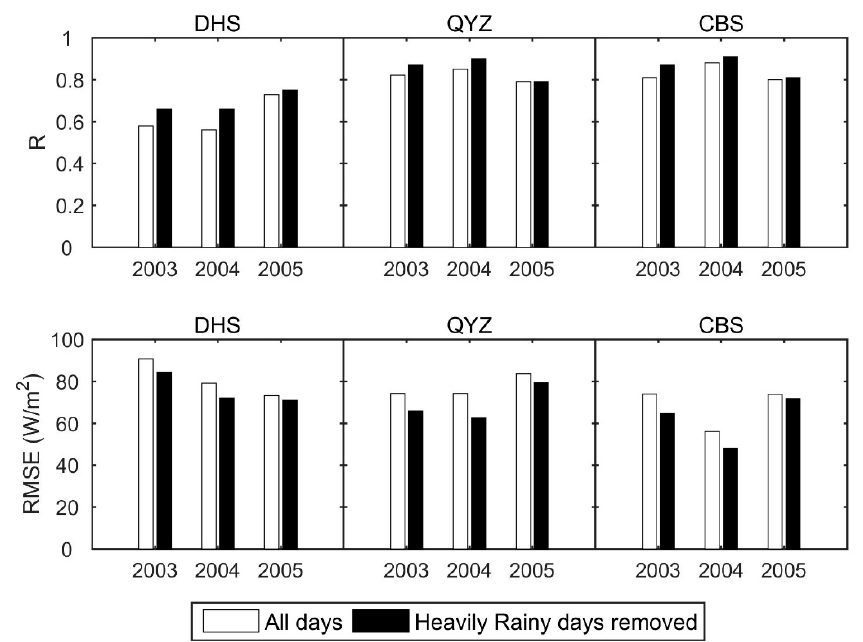
Figure 8. Comparison results of all LE estimations (white bars) and the LE estimations after removing the heavily rain-contaminated days (black bars).